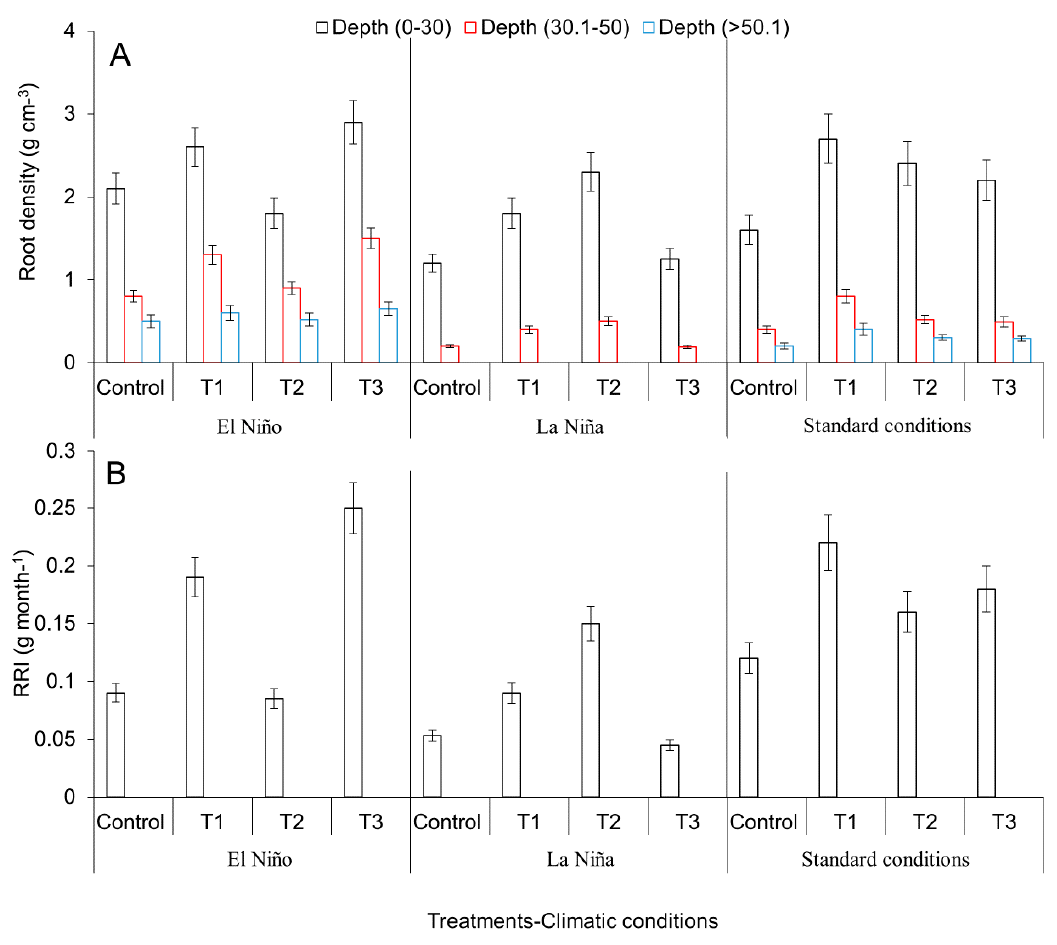
Figure 5. Variation of root density ( A ) and relative rate increase of dry plant weight ( B ) values as effect of the application of agronomical practices aimed to mitigate the adverse effects of the ENSO phenomenon (El Niño and La Niña) under field conditions. T1, new tools (plants with genetic identity, free of pathogen and root damage and planted under conditions of low alteration of the micro-drainage networks) implemented under field conditions and the native avocado genotype with the best performance to waterlogging, drought, graft compatibility and resistance/tolerance to P. cinnamomi and Verticillium sp; T2, practices implemented in T1 + the native avocado genotype with the best performance for waterlogging conditions; T3, practices implemented in T1 + the native avocado genotype with the best performance under drought conditions; Control, traditional system implemented in avocado producing farms. Error bars represent the confidence intervals of the mean, validated by Dunnett’s, and Tukey–Kramer separation tests. No overlapping of the error bars indicates significant di ff erences ( p >